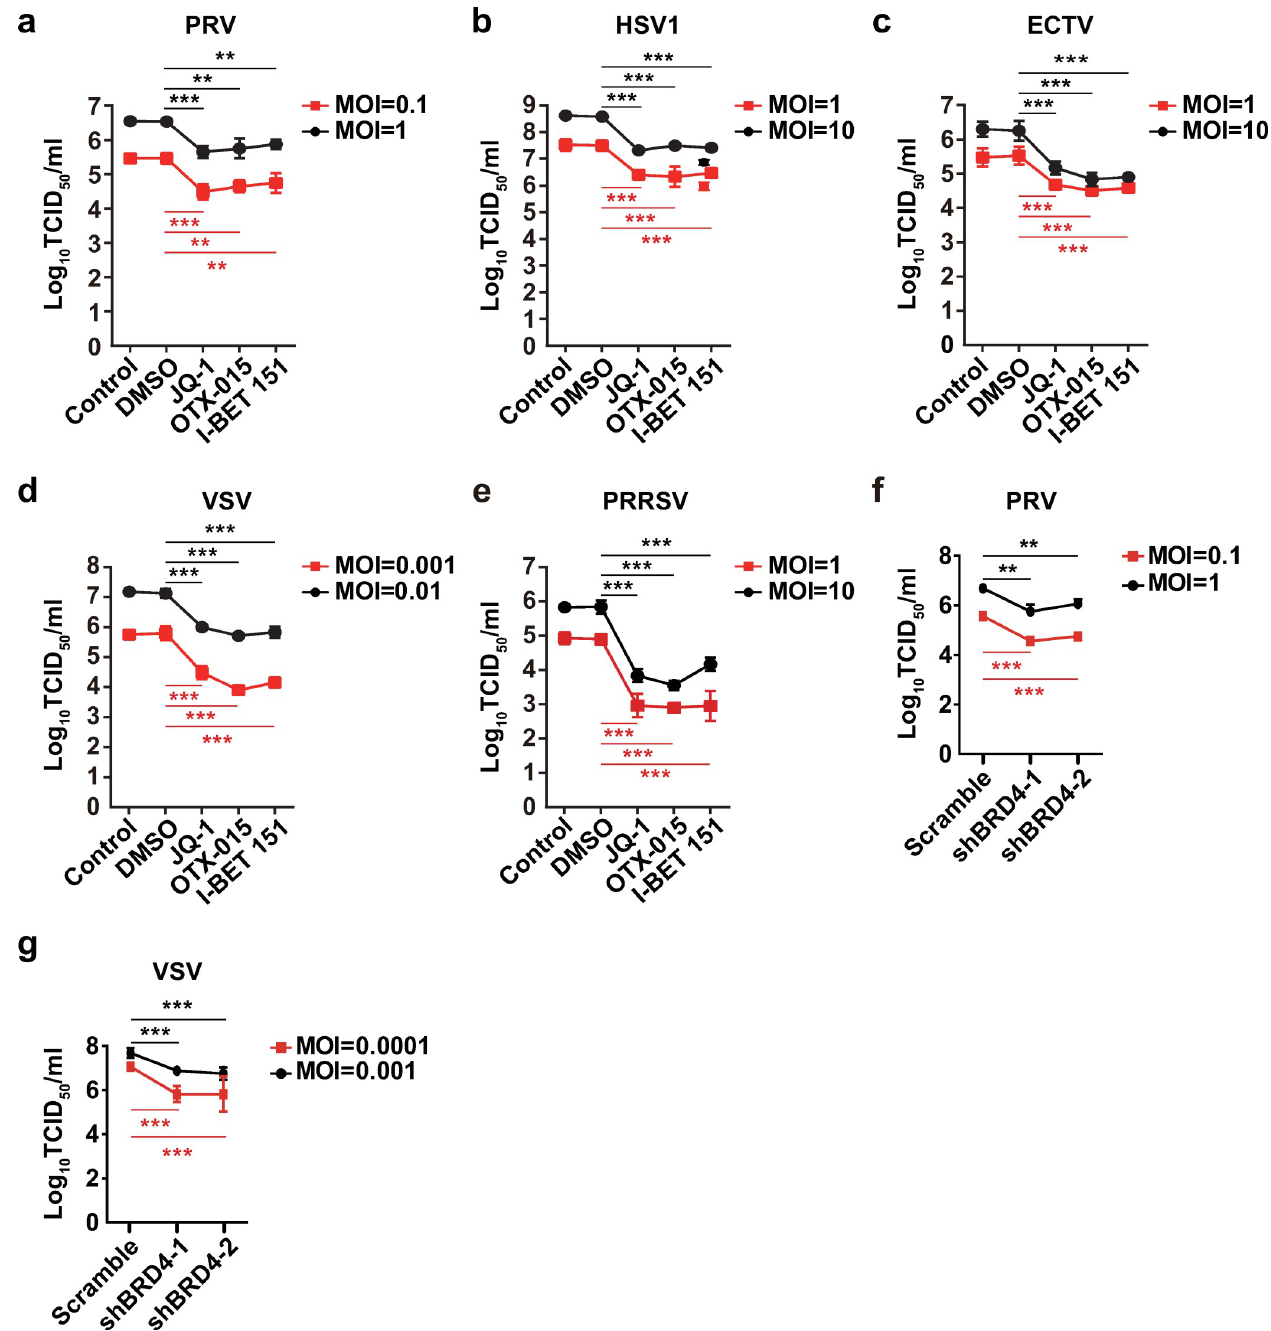
Fig 3. BRD4 inhibition exerts broad-spectrum antiviral activity. (a) Viral titer was assessed with TCID 50 assays in PK15 cells (Control) infected with PRV-QXX (MOI = 0.1 and 1) and treated with DMSO, JQ-1 (1 μ M), OTX-015 (10 μ M) and I-BET 151 (10 μ M) for 24 h. (b) Viral titer was assessed with TCID 50 assays in A549 cells (Control) infected with HSV1-F (MOI = 1 and 10) and treated as in a. (c) Viral titer was assessed with TCID 50 assays in Vero cells (Control) infected with ECTV (MOI = 1 and 10) and treated as in a. (d) Viral titer was assessed with TCID 50 assays in PK15 cells (Control) infected with VSV-GFP (MOI = 0.001 and 0.01) and treated as in a. (e) Viral titer was assessed with TCID 50 assays in MARC-145 cells (Control) infected with PRRSV-BJ4 (MOI = 1 and 10) and treated as in a. (f and g) Viral titer was assessed with TCID 50 assays in Scramble, shBRD4-1 and shBRD4-2 PK15 cells infected with PRV-QXX (f, MOI = 0.1 and 1) and VSV-GFP (g, MOI = 0.001 and 0.01) for 24 h. All data are shown as mean ± SD based on three independent experiments. �� P < 0.01, ��� P < 0.001 determined by two-tailed Student’s t -test.